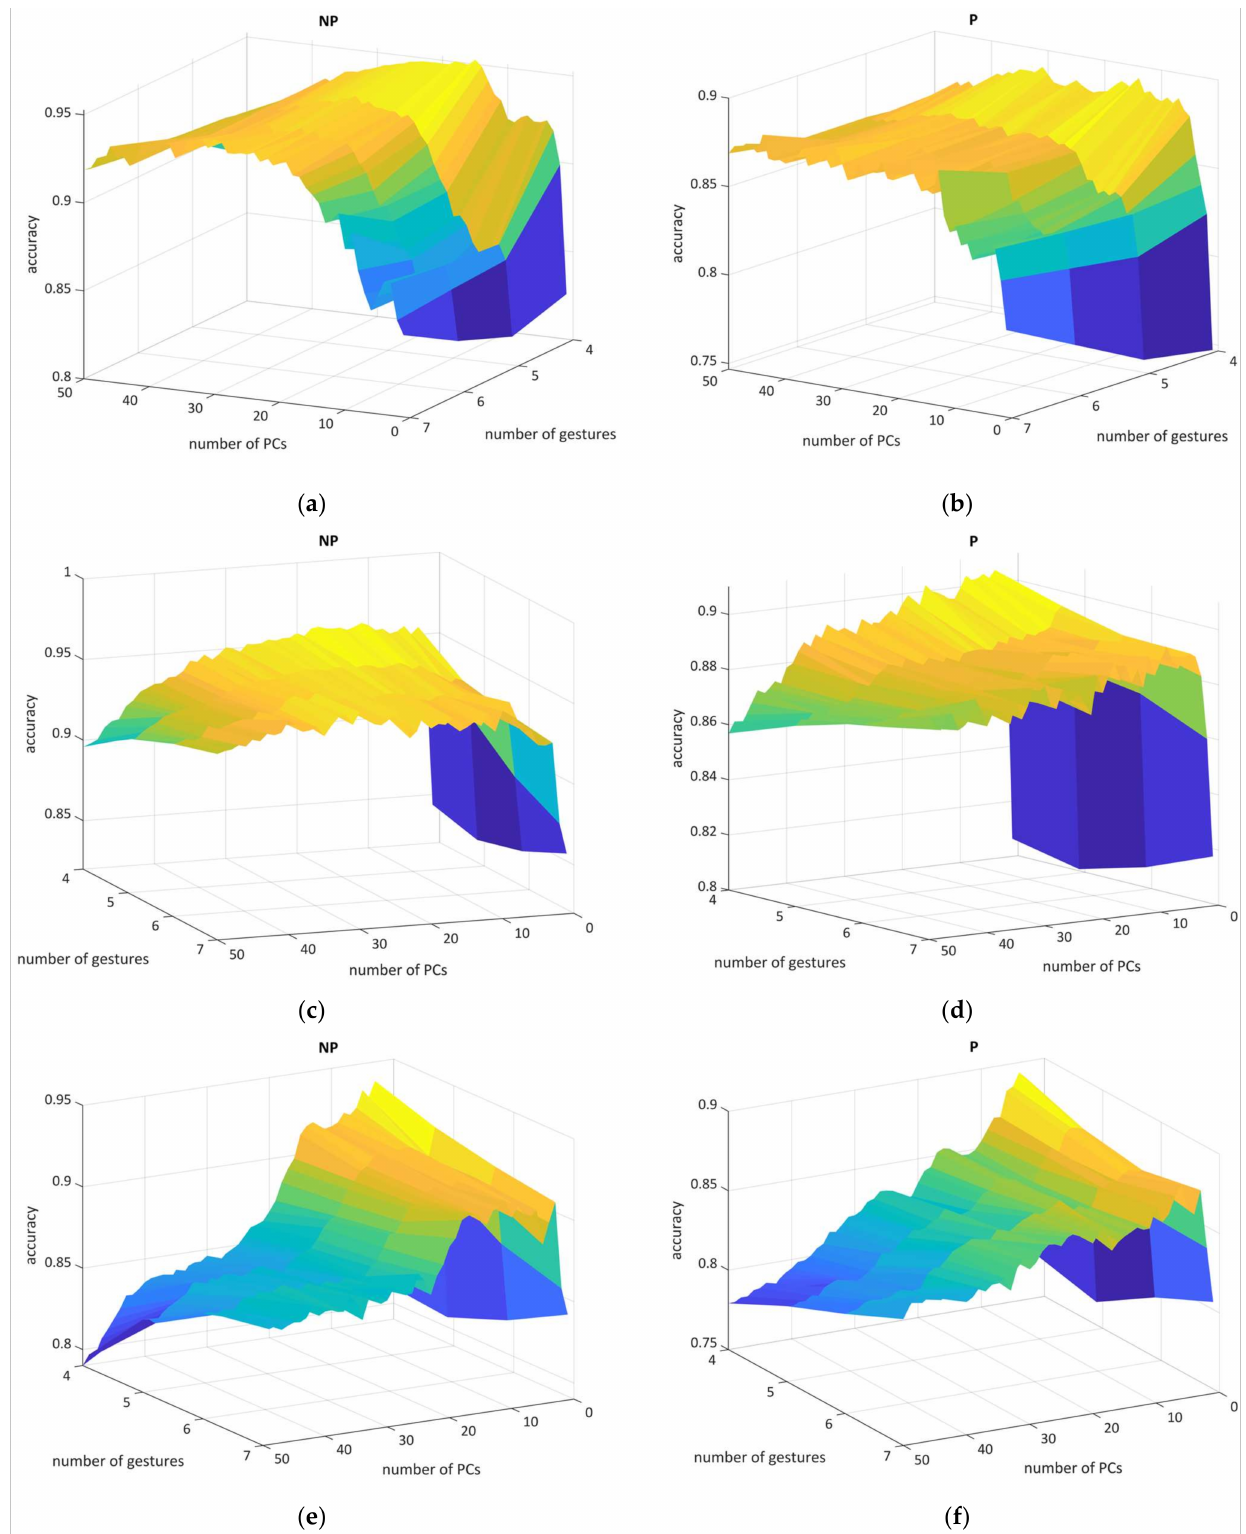
Figure 4. The 3D mesh illustrates the relationship between GLs in paretic and non-paretic datasets (left figures obtained from NP19, right from P19), number of PCs, and accuracy: ( a , b ) SVM, ( c , d ) LDA, and ( e , f ) k-NN performance. The color heatmap mesh represents the accuracy result range from dark blue (lower scores) to yellow (higher